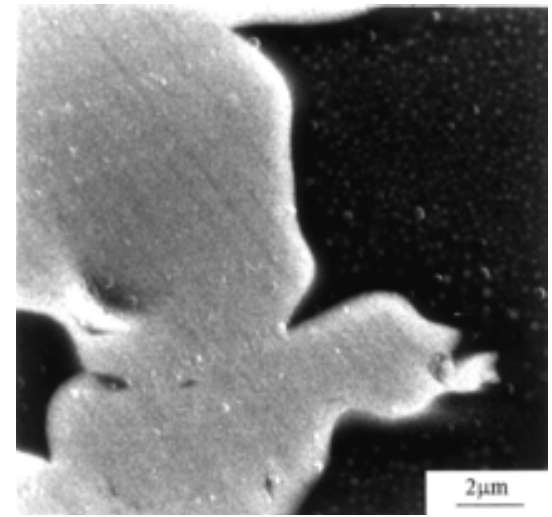
Figure 9. Transversal cut on the glass infiltrated region in zirconia plate showing glass phase separation (small spheres in the black regions) done at 1610 °C by G1 glass composition.